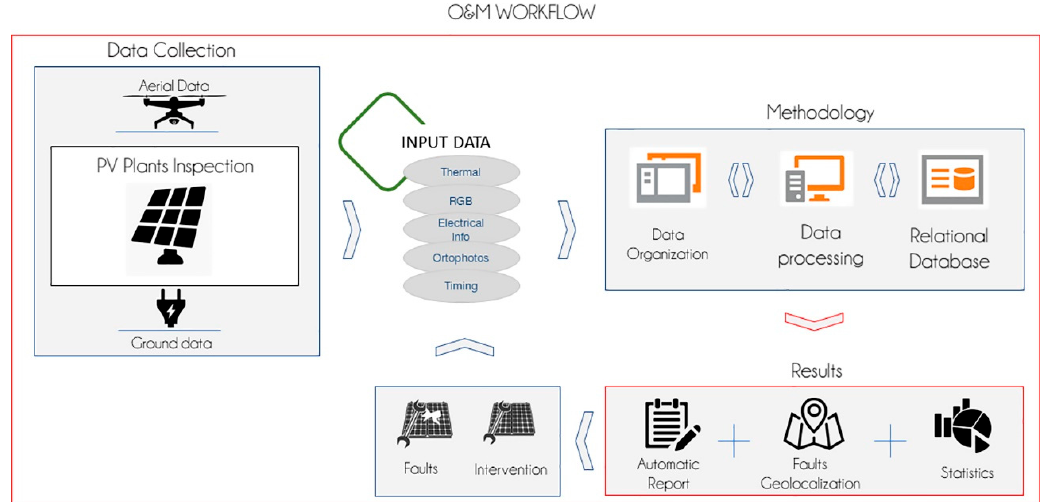
Figure 6. Workflow of the methodology adopted for the O&M in PV plants. The pipeline starts with the data acquisition from aerial and ground sources; such data are the input managed within the GIS solution, following the relational conceptual model. As a result, the user can extract all the information for a more efficient O&M. O&M is seamless, as data can be constantly updated.